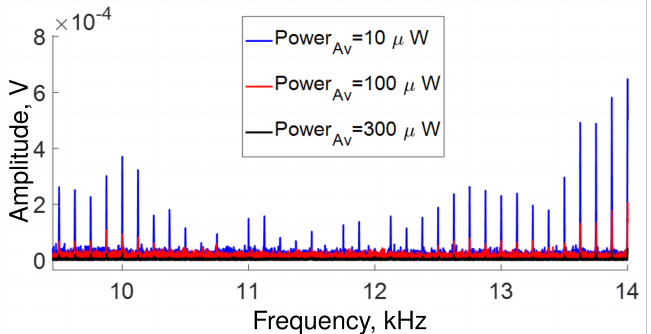
Figure 6. Low-response region for frequencies detected during 1 s in our setup for several average power measured at the output and adjusted by the angle α of QWR (see Figure 1).